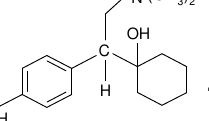
Figure 1. Chemical structure of venlafaxine